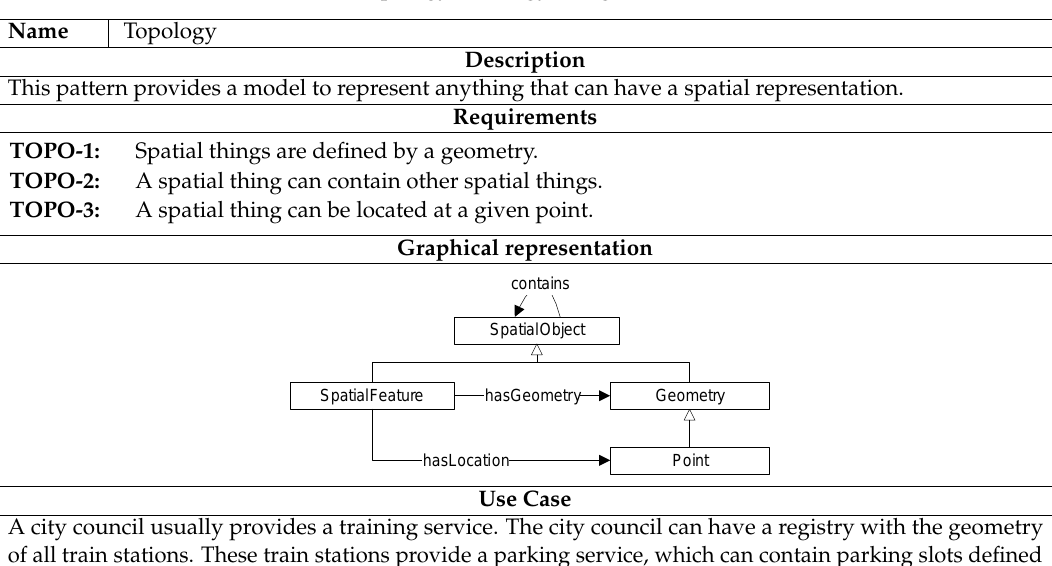
Table 6. Topology Ontology Design Pattern